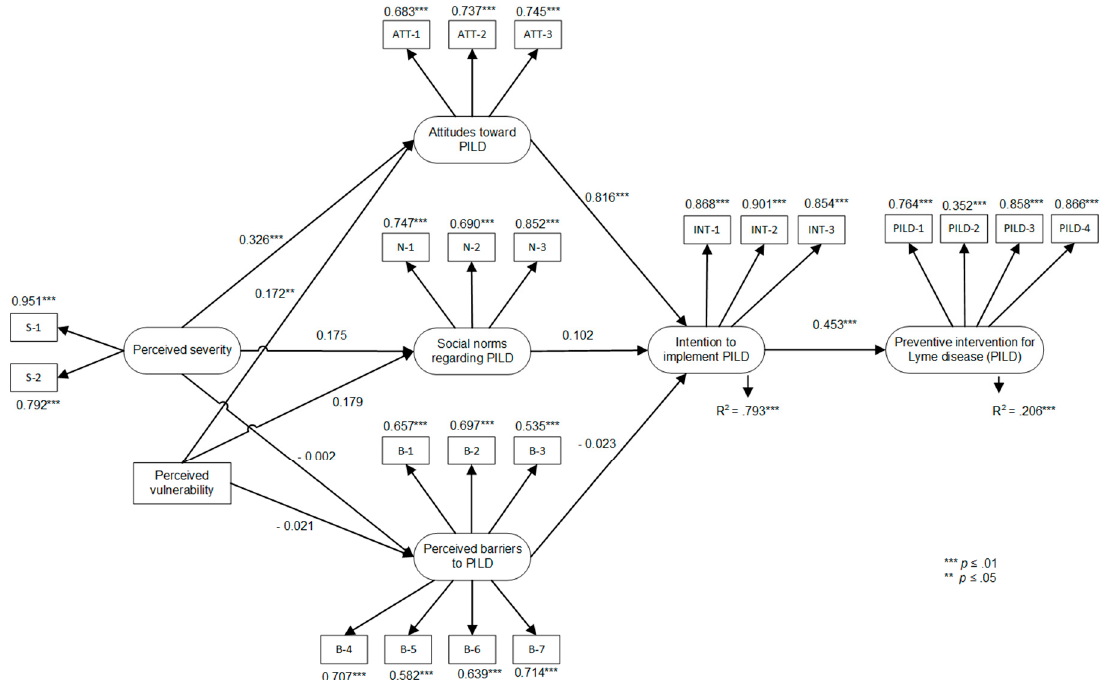
Figure 2. TPB and health belief model (HBM) variables predicting the implementation of preventive interventions for Lyme disease. Note . Correlations between predictor variables were: 0.584 *** between attitude and perceived social norms; − 0.288 *** between attitudes and perceived control (barriers) over the implementation of PILD; − 0.043 between social norms and perceived control (barriers) over the implementation of PILD; and 0.272 *** between perceived vulnerability and perceived severity. ** p < 0.05. *** p < 0.01.